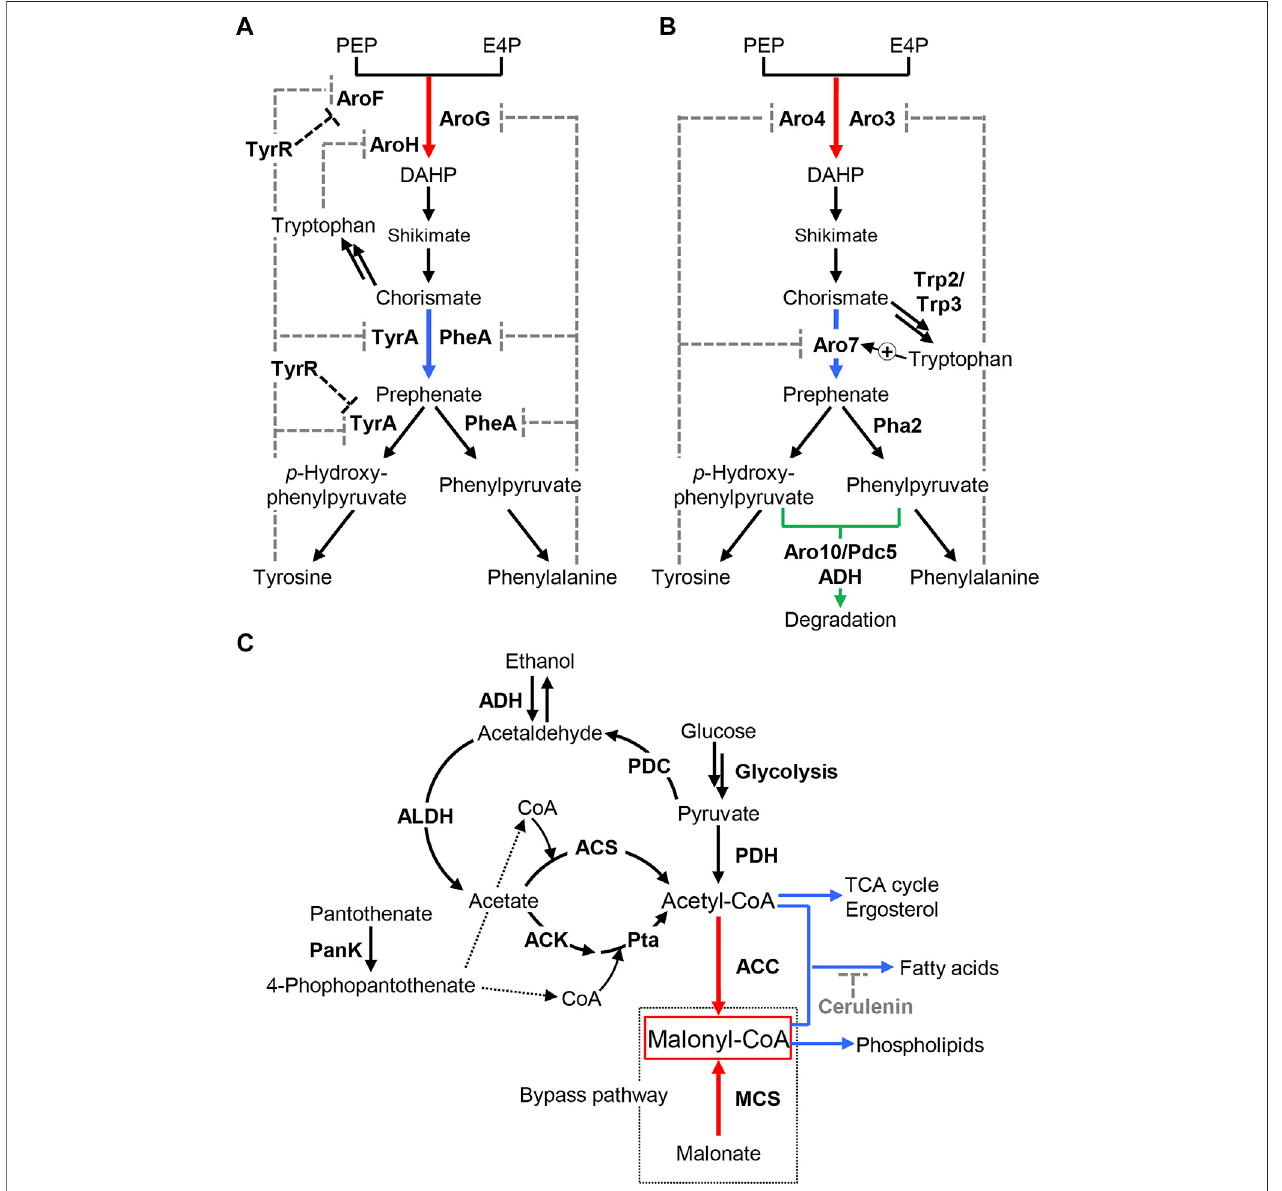
FIGURE3| Metabolicengineeringofendogenousbiosynthetic pathways forprecursors. (A,B) Biosynthesis ofaromaticamino acidsin E.coli (A) and S.cerevisiae (B) .Phenylalanineandtyrosinearesynthesized via theshikimatepathway.DAHPsynthaseandchorismatemutase,whichcatalyzethe fi rstandlaststepoftheshikimate pathway, respectively, are subjected to feedback regulation by aromatic amino acids (indicated by gray-dashed lines). Chorismate is bypassed to tryptophan. Red and blue arrows indicate the enzymatic reactions catalyzed by DAHP synthase and chorismate mutase, respectively. (A) The transcriptional regulator TyrR represses the expression of genes involved in the biosynthesis of phenylalanine and tyrosine, such as aroF and tyrA (indicated by black-dashed lines). (B) The enzymatic activity of Aro7 is activated by tryptophan. Green arrow indicates degradation of phenylpyruvate and p -hydroxyphenylpyruvate, precursors of phenylalanine and tyrosine, respectively, to the corresponding alcohols by decarboxylases, Aro10, and Pdc5, and alcohol dehydrogenase (ADH). PEP: phosphoenolpyruvate, E4P: D -erythrose-4- phosphate, DAHP: 3-deoxy- D -arabino-heptulosonate 7-phosphate. (C) Biosynthesis of malonyl-CoA. Endogenous malonyl-CoA is synthesized from acetyl-CoA by ACC. MCS catalyzes the formation of malonyl-CoA from malonate, which is used as the bypass pathway in malonyl-CoA synthesis, in addition to the natural metabolic pathway. Acetyl-CoA is synthesized in the PDH complex from pyruvate and by ACS from acetate in S. cerevisiae . The Ack-Pta pathway from acetate is also used in addition to these biosynthetic pathways in E. coli . PanK catalyzes the phosphorylation of pantothenate to 4-phospho pantothenate, a precursor of CoA. Red arrows represent two key enzymatic reactions for directly increasing intracellular malonyl-CoA, which are catalyzed by ACC ant MCS. Whereas, blue arrows indicate pathways for acetyl-CoA consumption by glycolysis, the TCA cycle, and fatty acid synthesis, and malonyl-CoA consumption by the synthesis of fatty acids and phospholipids. Cerulenin inhibits fatty acid synthesis as indicated by grey dotted line. Pyruvate, a precursor for acetyl-CoA, is catabolized to acetate, another precursor of acetyl-CoA, and ethanol via acetaldehyde. The reaction catalyzed by ADH is bi-directional; thus, overexpression of ADH that prefers to convert ethanol to acetaldehyde, such as Adh2 in S. cerevisia e, was used for increasing acetate availability. ACC, acetyl-CoA carboxylase; MCS, malonyl-CoA synthetase; PDH, pyruvate dehydrogenase; ACS, acetyl-CoA synthetase; Ack, acetate kinase; Pta, phosphate acetyltransferase; PDC, pyruvate decarboxylase; ADH, alcohol dehydrogenase; ALDH, acetaldehyde dehydrogenase; PanK, pantothenate kinase.